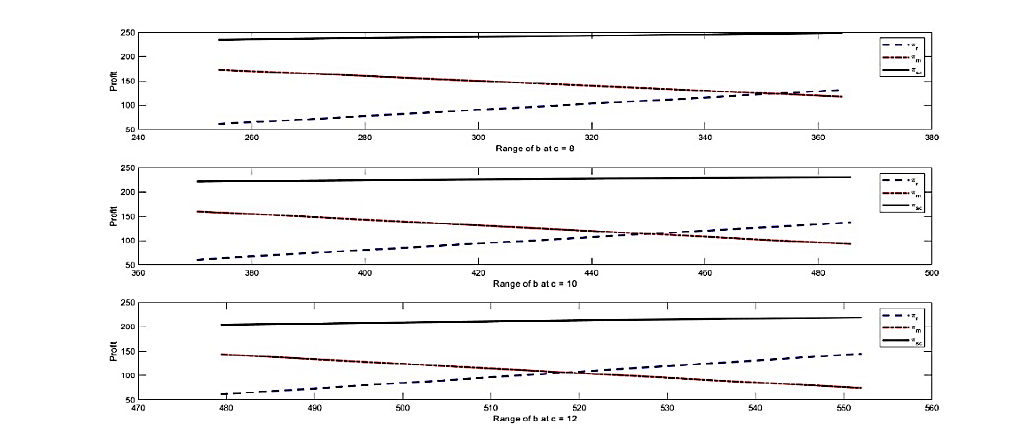
Fig. 8. The trend of variations in firms' profits due to variations in production costs